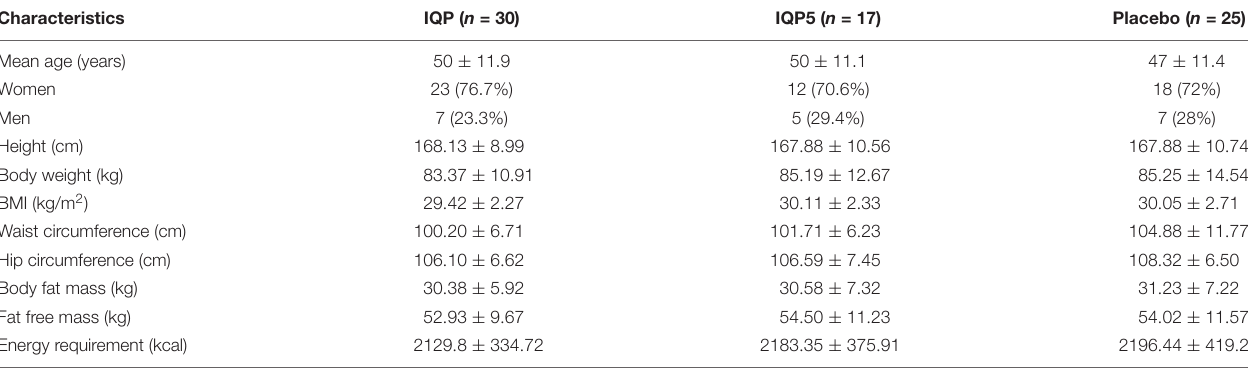
FIGURE 1 | Flowchart of the study population from the start until the end of the study. TABLE 2 | Baseline demographic of the study population (mean ± SD) or number (%) of